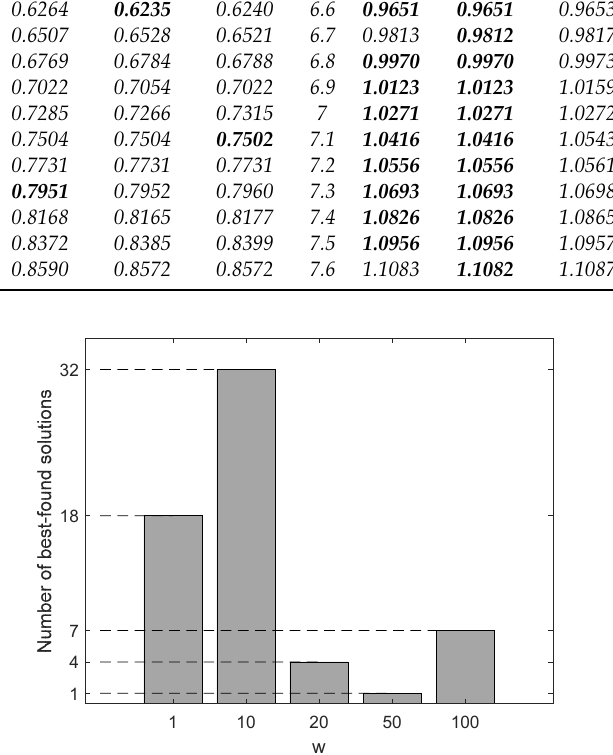
Figure 12. The number of best-found solutions for different w values. Table 4. Experimental setup